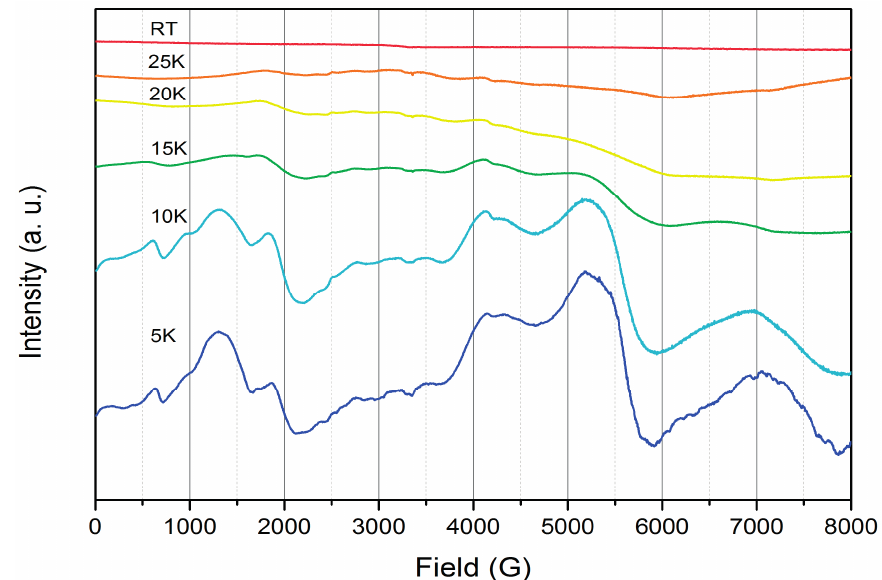
Figure 5. Variable temperature powder X-band EPR spectra of 2 ( v = 9.385